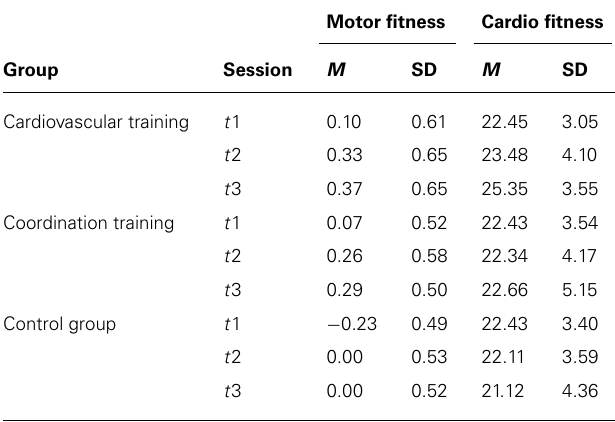
Table 4 | Mean (M) and Standard deviation (SD) for motor fitness ( z -value of overall motor fitness index) and cardiovascular (cardio.) fitness for all three measurement time points ( t 1, t 2, t 3) and for the two experimental groups (cardiovascular training, coordination training) and the control group (stretching and